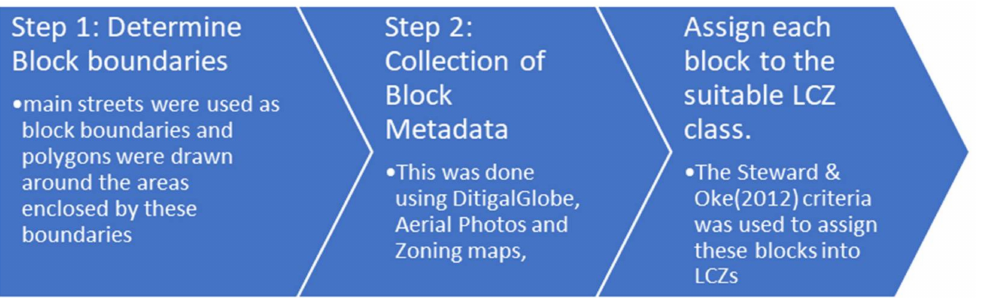
Figure 3. An outline of the city block method steps for accurately creating training polygons and assigning them to different LCZ for the classification